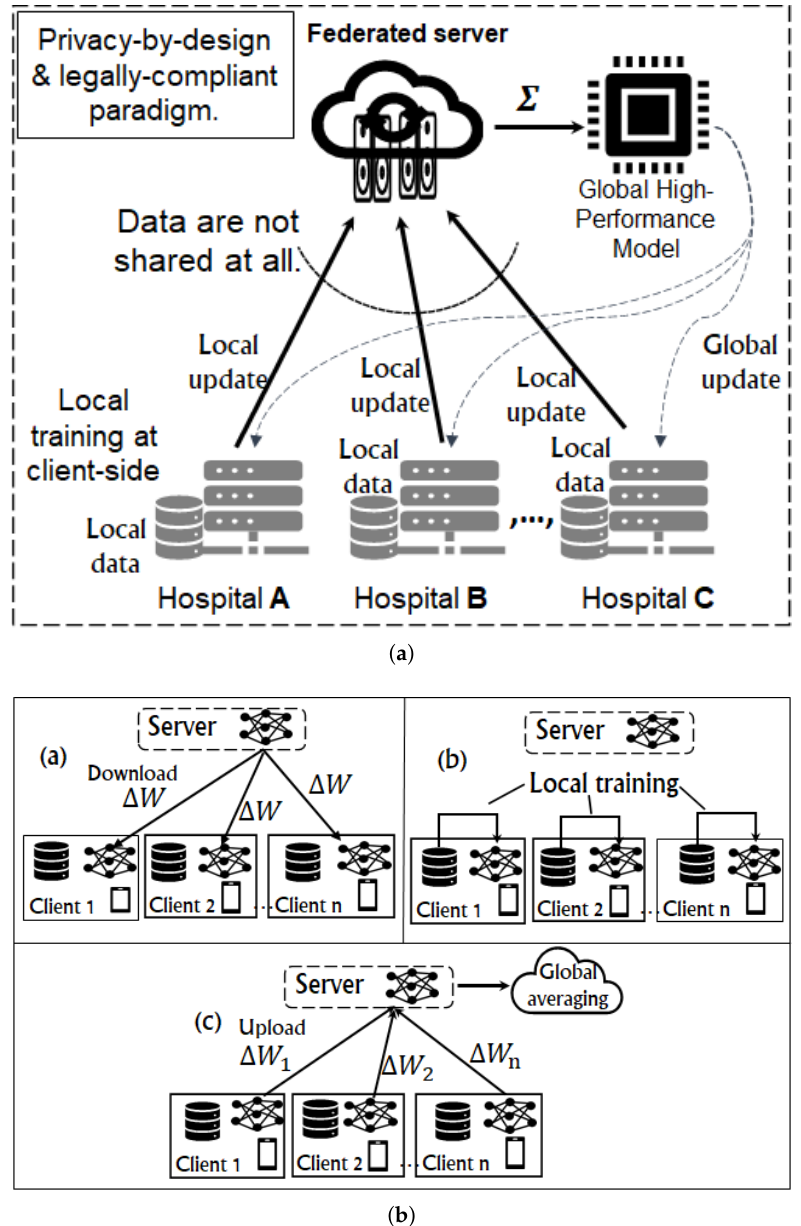
Figure 1. Technical overview of the FL paradigm. ( a ) Overview of FL paradigm; ( b ) Practical illustration of one round of FL (reformulated from